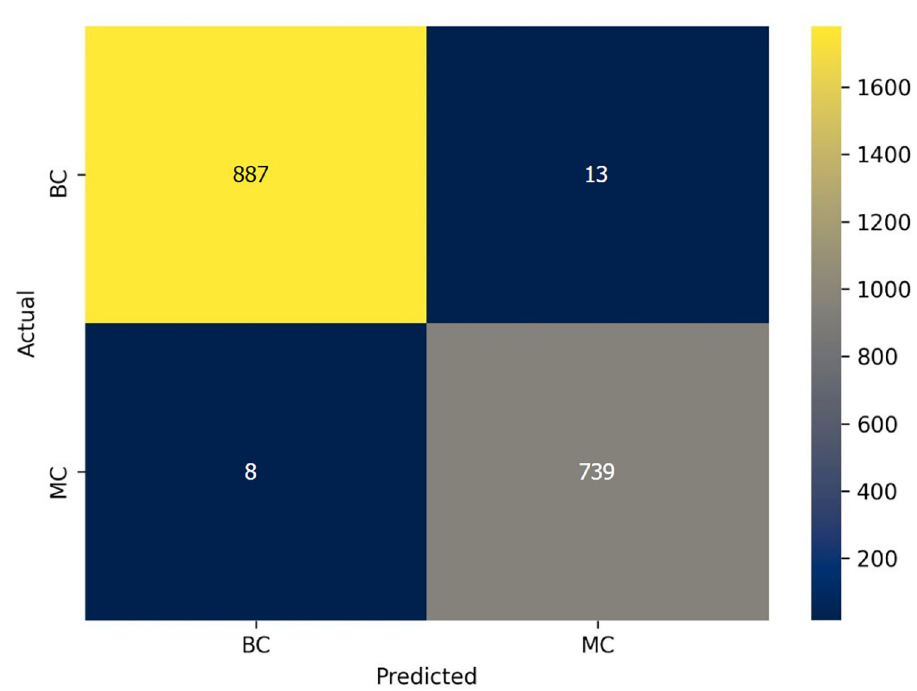
Fig 26. Confusion matrix of the best configured model (Adam 0.001).